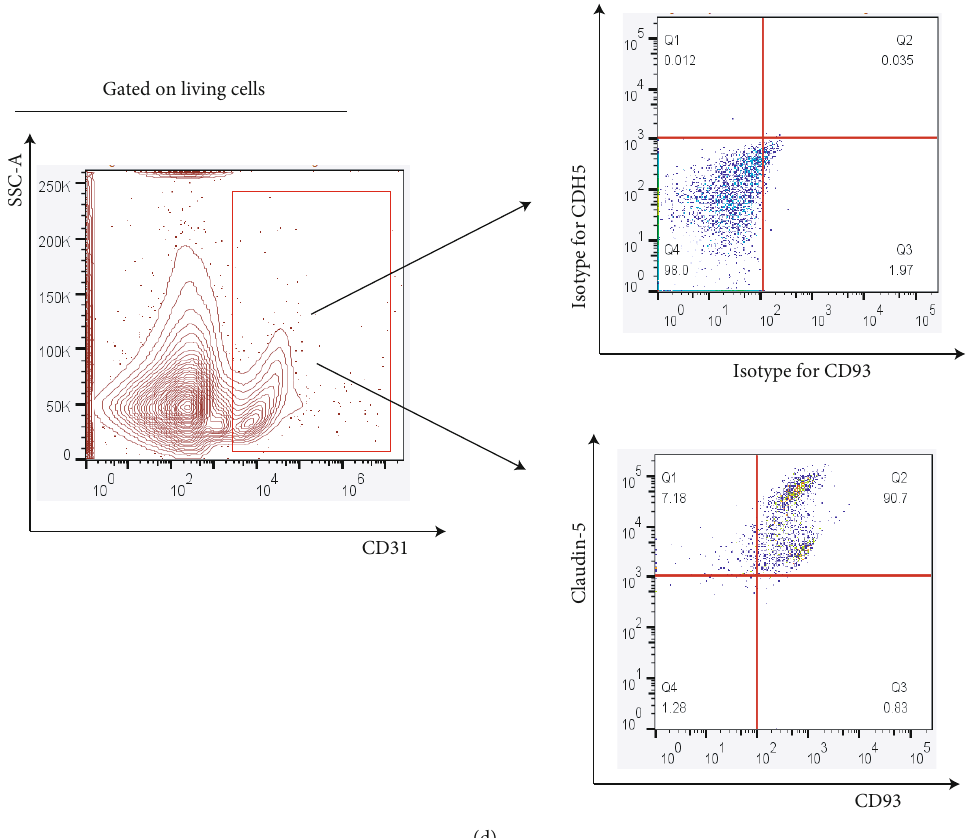
Figure 1: Identi fi cation of endothelial cells in TNBC biopsies. (a) Flow cytometry analysis revealed three endothelial cell subclusters in TNBC biopsied tissues, featured by the expression of ATP1B3, HSPA1B, and KRT7, respectively. Data represent similar results acquired from fi ve independent experiments. (b) UMAP plots showed 9 cell types in the normal human breast and 10 cell types in TNBC biopsy tissues. The boxed cell types indicate endothelial cells. (c) Violin plots exhibited the expression pattern of endothelial cell markers (CD93, CDH5, and PECAM1) and a leukocyte marker (PTPRC). (d) Flow cytometry analysis identi fi ed the expression of CDH5 and CD93 from endothelial cells in TNBC biopsies. Data represent similar results acquired from three independent